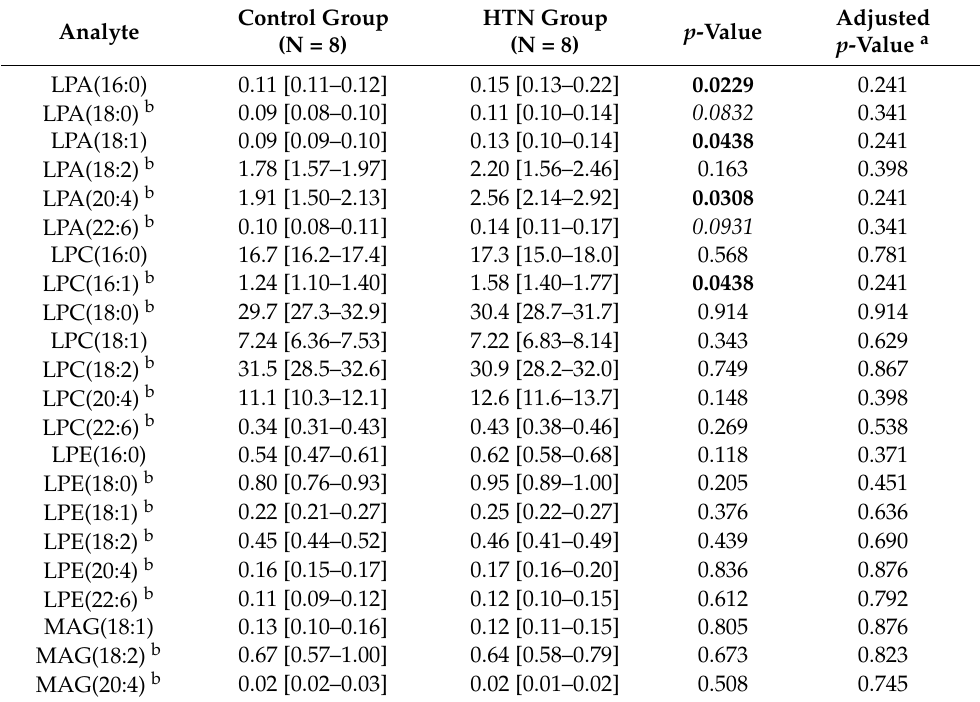
Table 1. Impact of Ang-II HTN on LPA, LPL and MAG